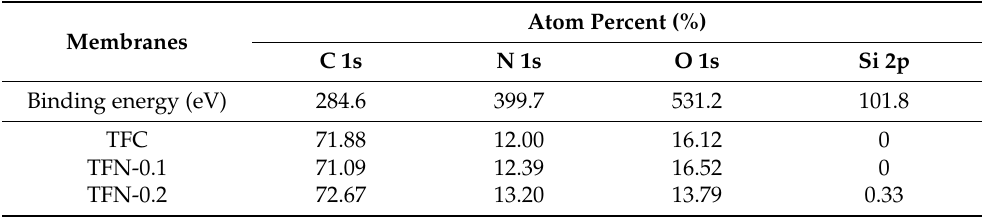
Table 1. Effect of loaded PTS on membrane element